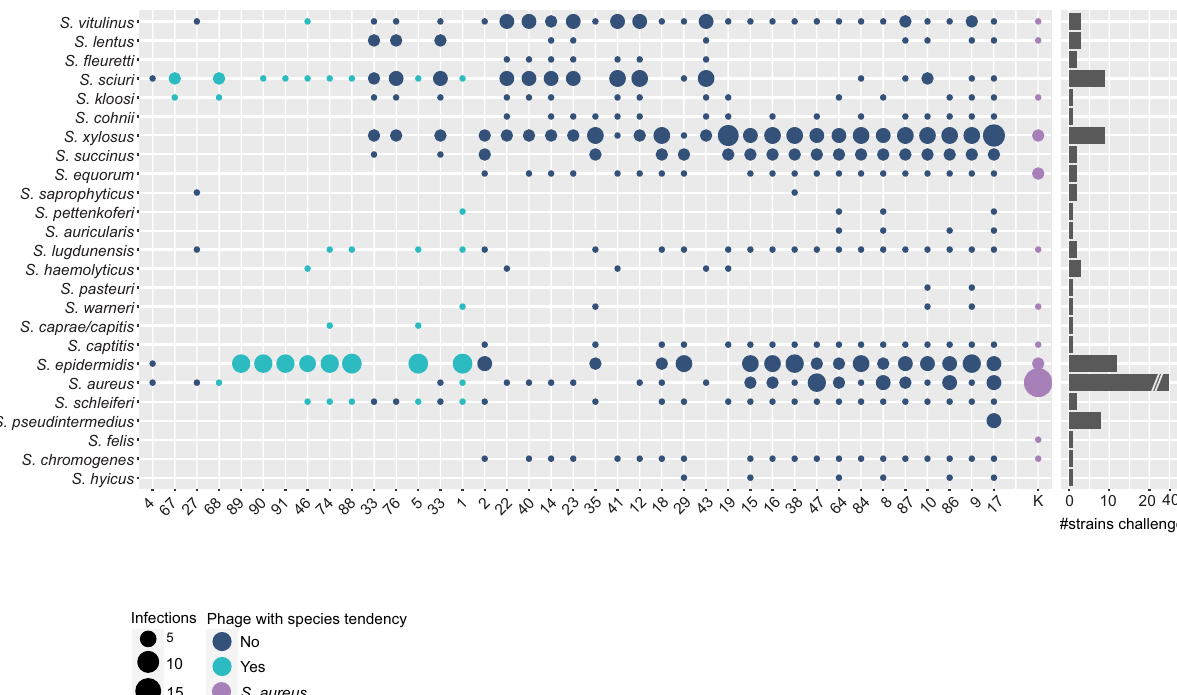
Fig. 3 Illustration of the host ranges collapsed on the species level for the 40 sequenced phages. Phages on the x -axis are sorted from narrow (left) to broad host range (right). Species on the y -axis are sorted after phylogenetic relationship in species groups 13 . A phage host range is depicted as a column, where infection of a staphylococcal species is illustrated using circles. For each respective species, the area of the circle is scaled according to the number of strains a phage can replicate on (scale: 1 – 15). The total number of strains challenged per species is depicted in the bar-chart on the right. Host ranges on this host array are colored as follows: Phage with species tendency ( ≥ 50% of all infections on a single species) in turquoise; phages with no clear species tendency in dark blue; polyvalent phage K in violet. Phages are abbreviated with their fi nal unique numerical identi fi er (PG-2021_*). Source data are provided as a Source Data fi